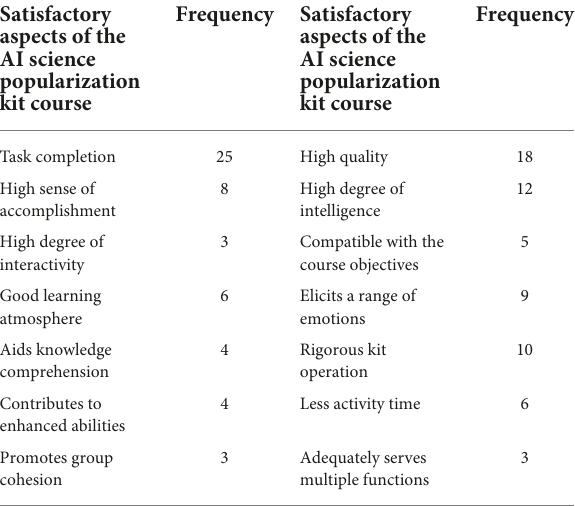
TABLE 1 Students’ (dis)satisfaction with extracurricular activities.